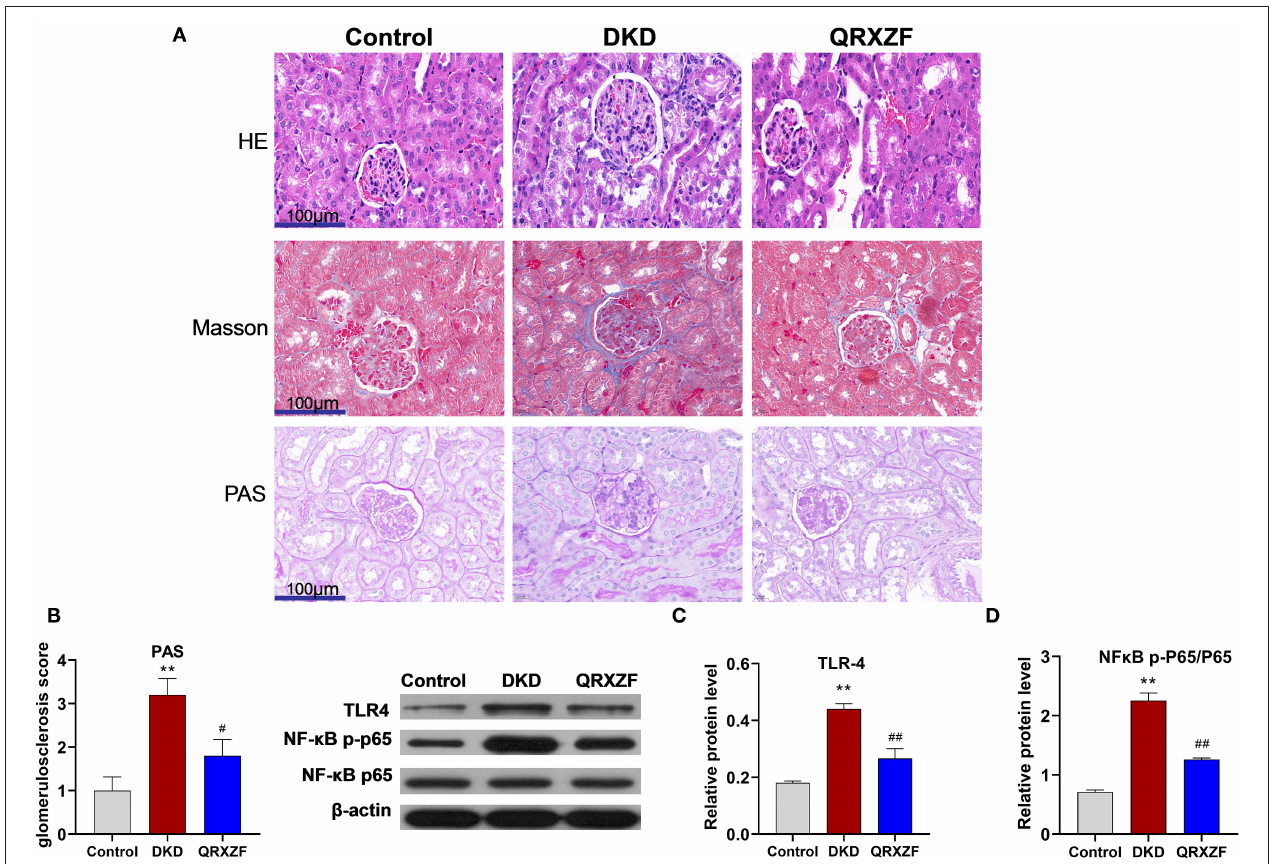
FIGURE 2 | QRXZF attenuated renal injury and inhibited inflammatory response in the kidney. (A) HE, Masson, and PAS stained at 400 × magnification, respectively; (B) PAS score; (C,D) western blot, expression of TLR4 and the ratio of NF- κ B p-p65 to NF- κ B p65 ( n = 3, means ± SEM). * P < 0.05, ** P < 0.01 DKD group vs. the control group; # P < 0.05, ## P < 0.01 QRXZF group vs. the DKD